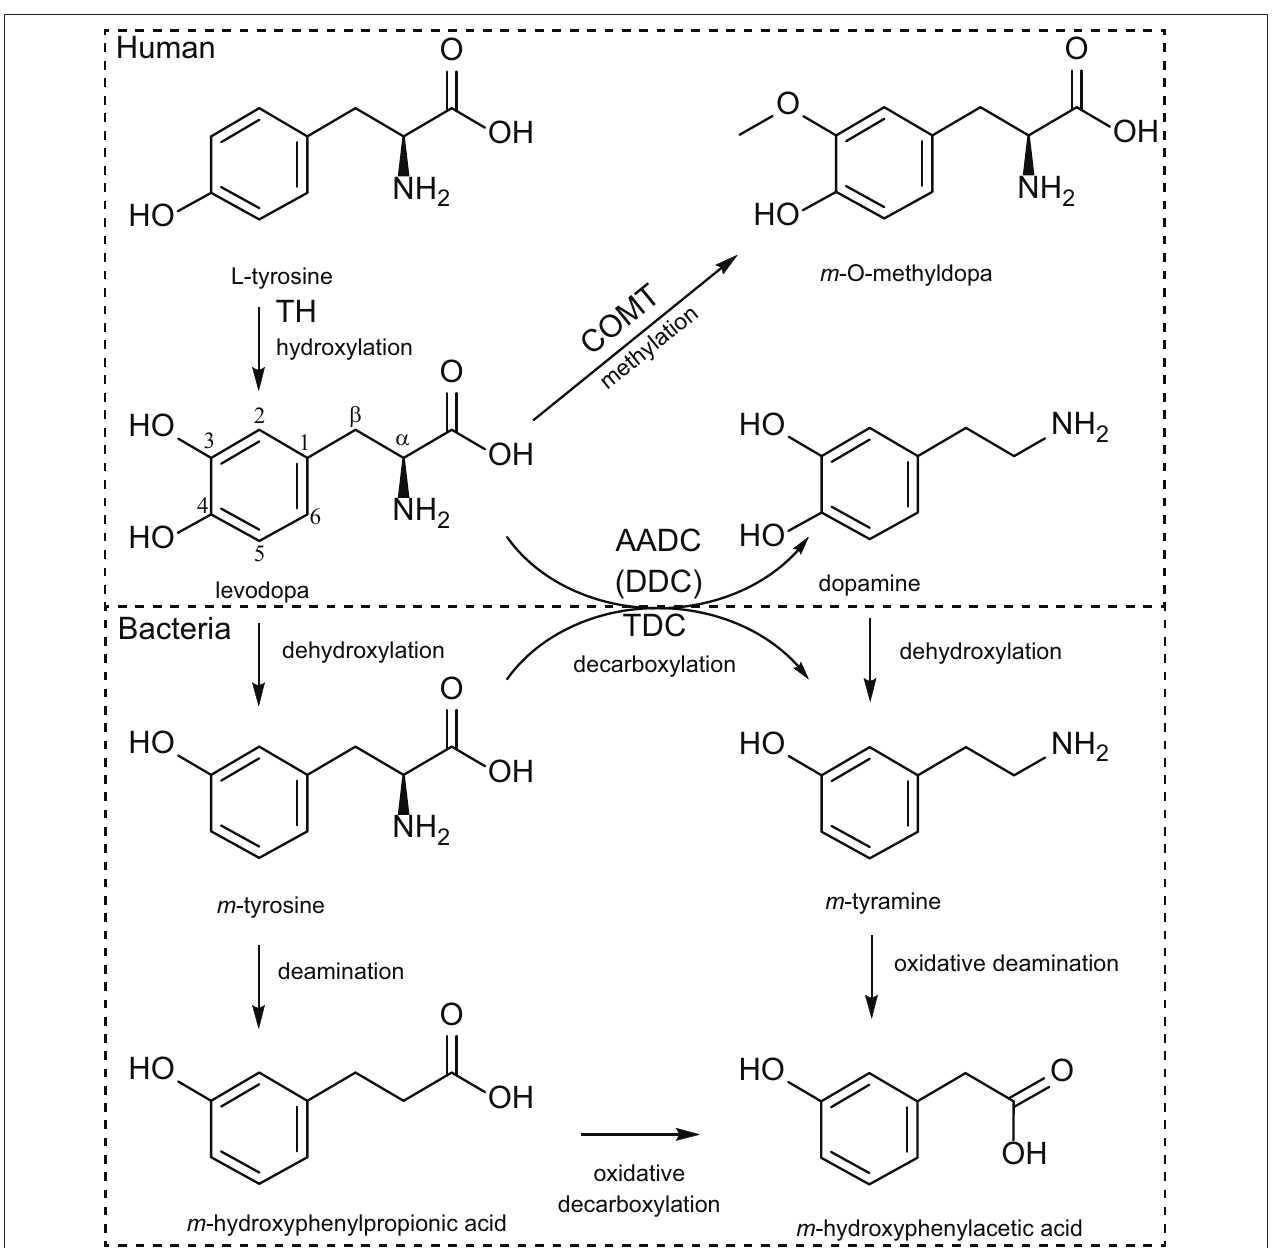
FIGURE 1 | Human and bacterial levodopa metabolism. Levodopa is produced by hydroxylation of the meta-position of the phenyl-ring from tyrosine by TH (tyrosine hydroxylase) using molecular oxygen. Sequentially levodopa can be decarboxylated to the active neurotransmitter dopamine by the AADC [aromatic amino acid decarboxylase, also known as DDC (DOPA decarboxylase)], or can be methylated by COMT (catechol-O-methyltransferase). Bacterial TDC (tyrosine decarboxylase) can decarboxylate ( m- )tyrosine to ( m- )tyramine but also levodopa to dopamine. Furthermore, bacteria can dehydroxylate the para-hydroxyl group of either levodopa or dopamine and can sequentially deaminate the dehydroxylated